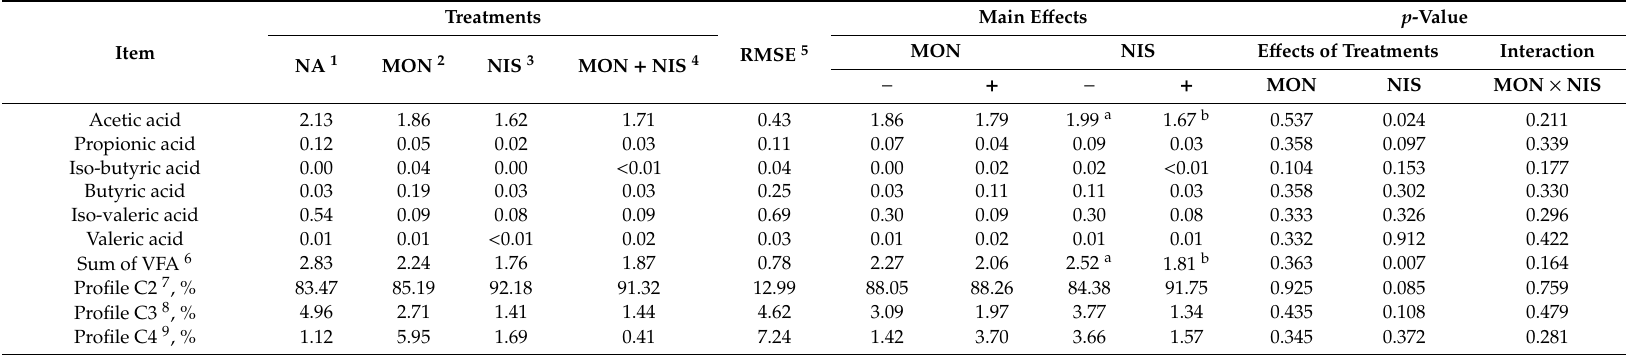
Table 6. The e ff ect of dietary supplementation of nisin alone or in combination with monensin on organic acid concentrations in the jejunal content ( µ mol / g), Experiment